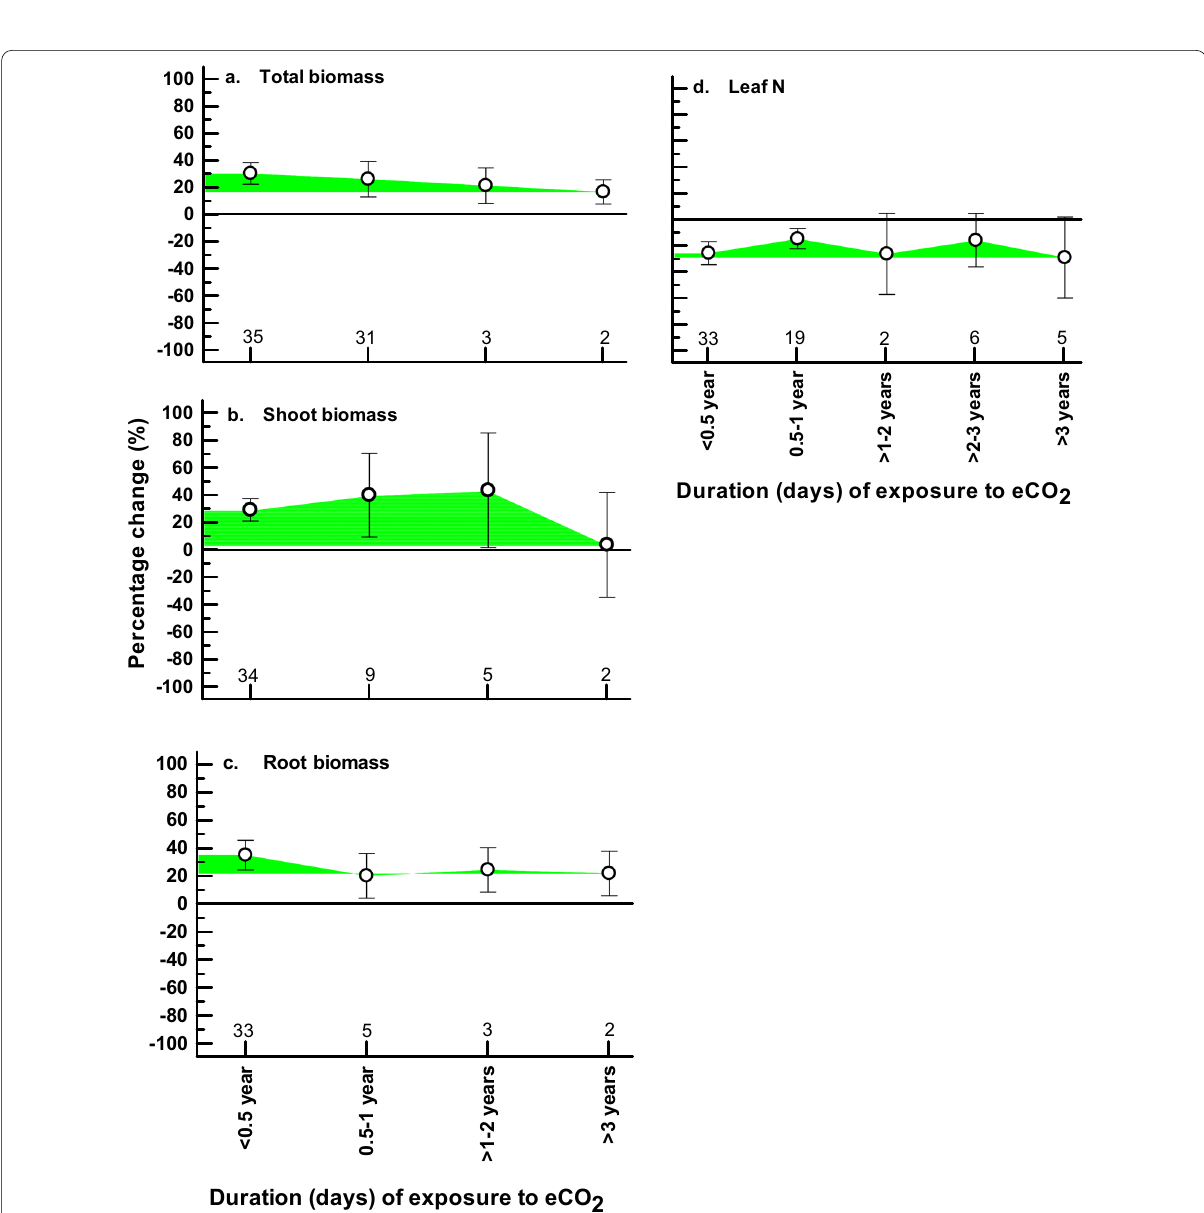
Fig. 4 Percentage change ( 95% CI) in biomass ( a – c ) and leaf N ( d ) of woody plants over different duration (years) of exposure to eCO 2 . The ± whiskers denote 95% CI and the circles denote mean percentage change (MPC) between aCO 2 and eCO 2 . The numbers above the major ticks of the X -axis denote number of observations. The area fill ( ) shows the trends and the magnitude of differences between the different duration of exposure to eCO 2 . The wider the area the bigger the difference between MPCs. Key to duration of exposure: 0.5 years denotes half of a year (6 months). There were no observations reported for a period > 2–3 years except for leaf